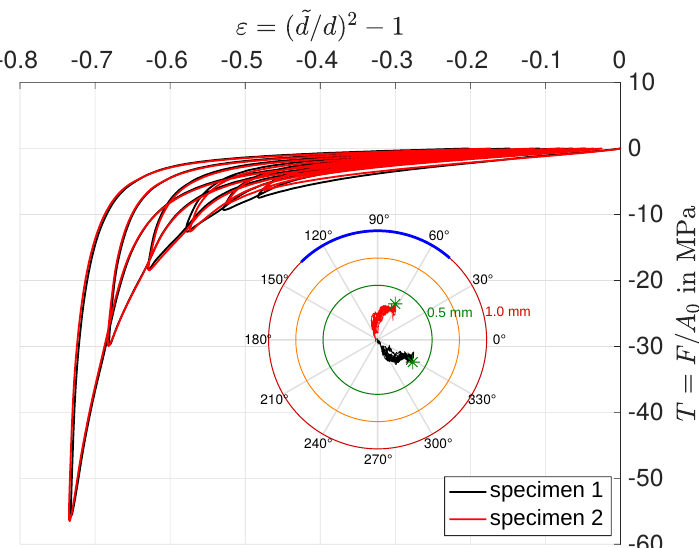
Figure 5. Stress–strain diagram for filled EPDM rubber, deformation analysis was performed with a 3D DIC measuring system (figure based on [20], labelling in